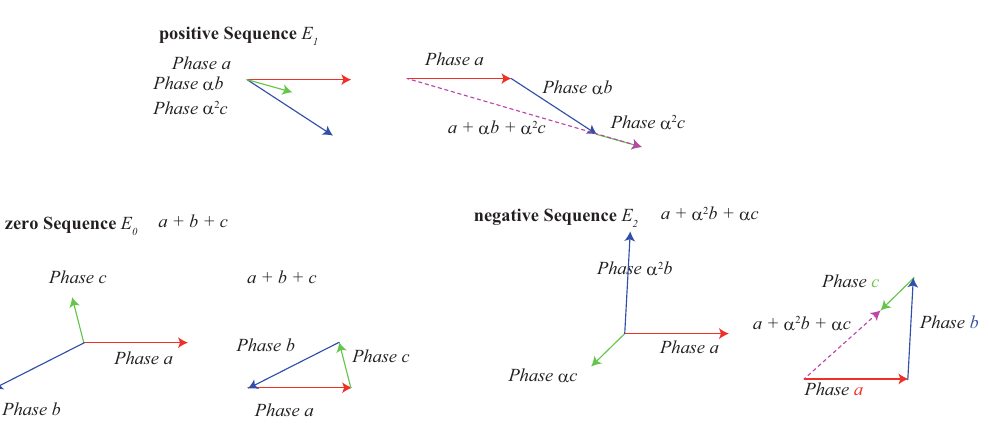
Figure 4. A visualization of the symmetrical components in unbalanced three-phase conditions.